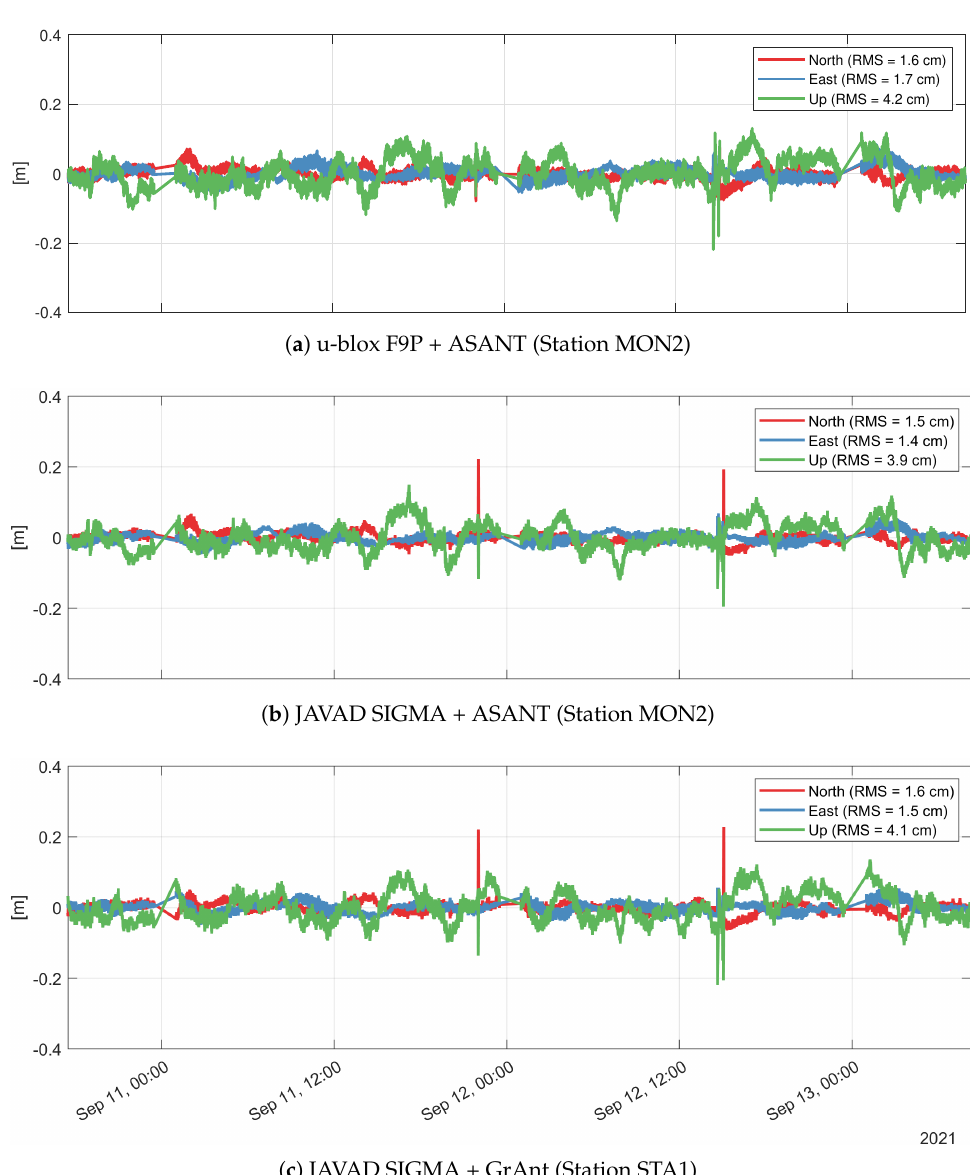
Figure 13. Session 2: results for the kinematic displacements obtained from the static experiments— ambiguity-float solution computed with